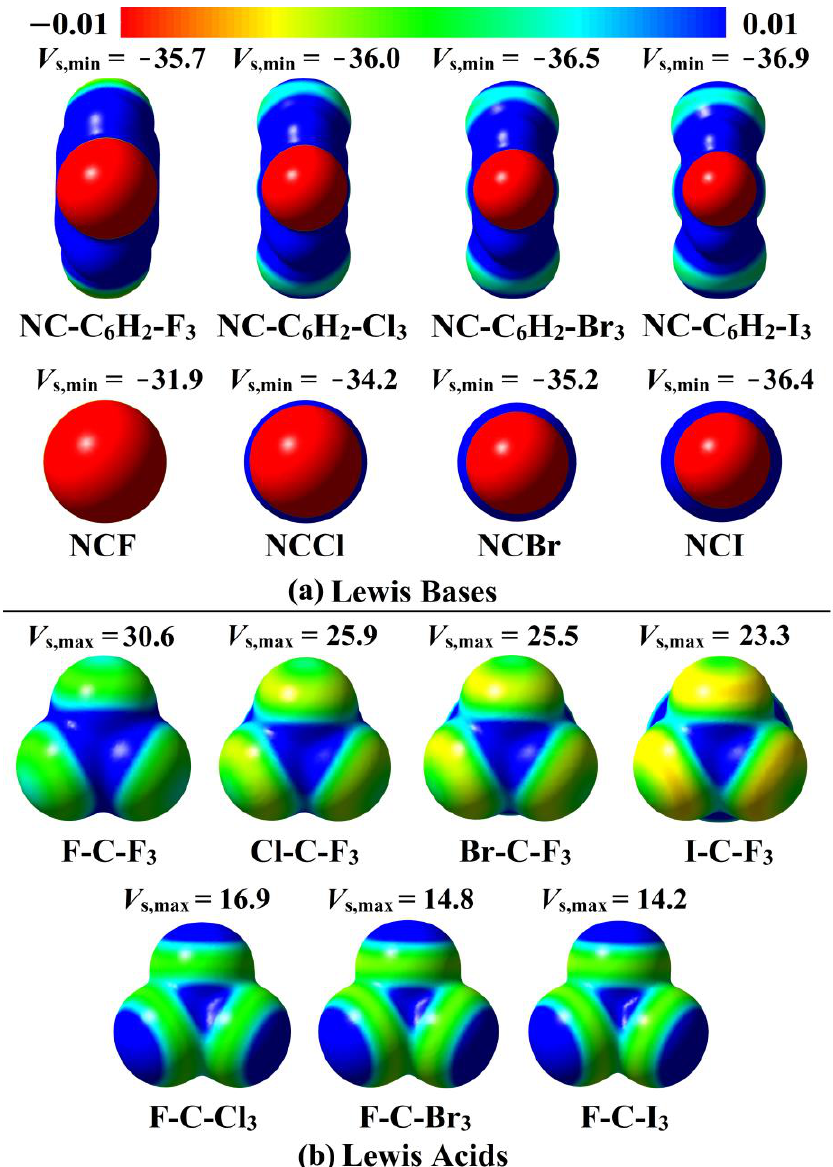
Figure 2. MEP maps of the utilized ( a ) NC-C 6 H 2 -X 3 and NCX Lewis bases (LB) and ( b ) W-C-F 3 and F-C-X 3 Lewis acids (LA) molecules. The EP in these maps aligned within the − 0.01 and +0.01 au range (red to blue colors). The V s,min / V s,max values are in kcal/mol. Passing to the inspected LA centres, notable positive EP regions (i.e., σ -hole) with From MEP maps shown in Figure 2, observable red (i.e., negative EP) regions different sizes were perceived (Figure 2). Evidently, σ -holes with more prominent sizes were observed within W-C-F 3 molecules compared with the F-C-X 3 counterparts, outlin- the later ones. For instance, the V s,max values of the I-C-F 3 and F-C-I 3 molecules were 23.3